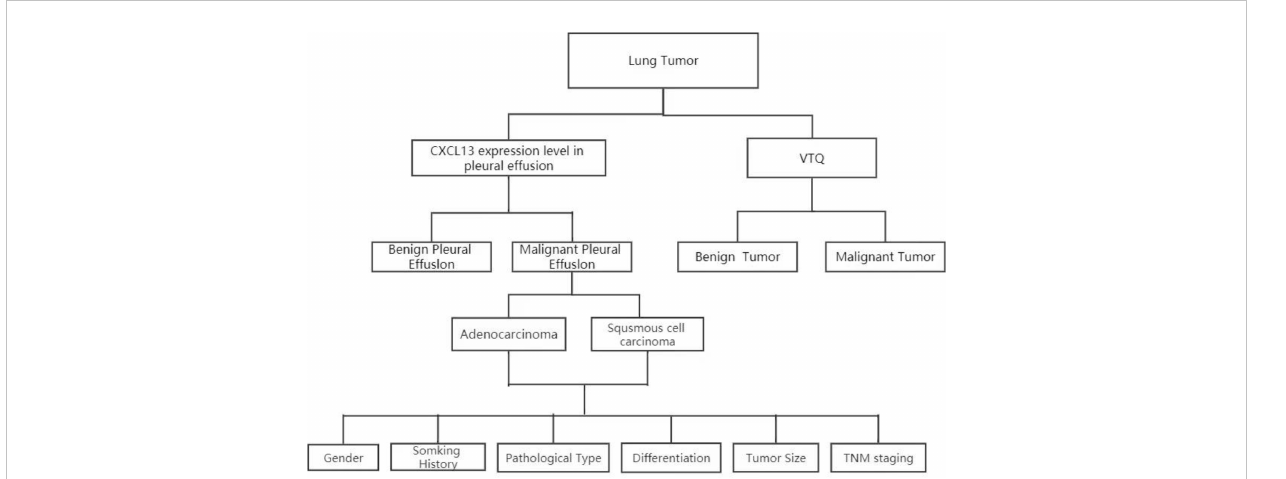
FIGURE 1 Analysis of CXCL13 and VTQ levels in patients with thoracic tumors and pleural effusion. Patient sample collection: Patients with thoracic tumors and pleural effusion were recruited; CXCL13 concentration measurement: The concentration of CXCL13 in pleural effusion was determined; VTQ measurement: Tissue quanti fi cation technology (VTQ) was applied to measure the numerical value of thoracic tumors; CXCL13 and clinical feature analysis: The relationship between CXCL13 and various clinical features was further analyzed; ROC curve analysis using SPSS software: The ROC curve analysis was performed using the multivariate observation values (CXCL13 and VTQ) in SPSS